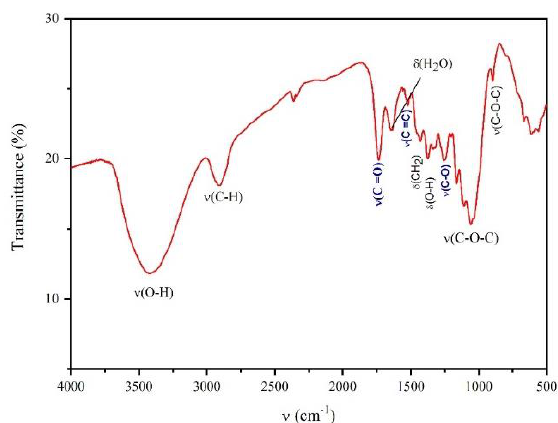
Figure 1. XRD pattern for the cellulosic material extracted from rose stems (CRS) sample, indicating the different associated crystalline planes.